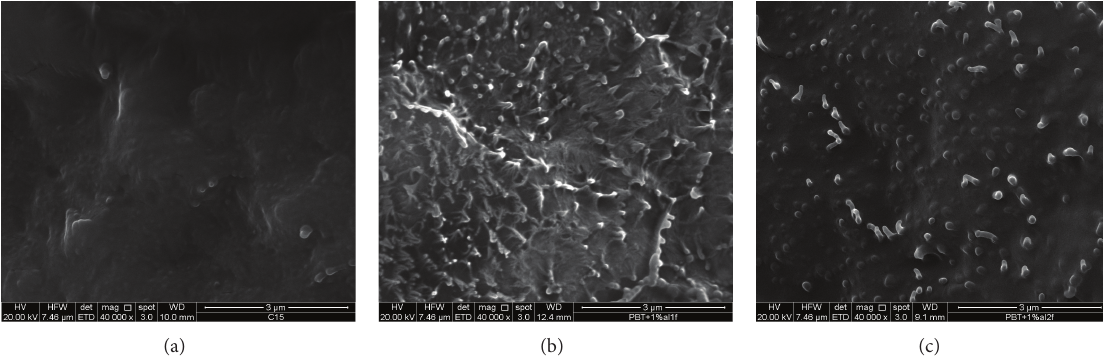
Figure 1: SEM micrographs of fracture surfaces of samples containing 1% by weight of alumina whiskers as received (a), functionalized with GPS (b), and functionalized with MPS